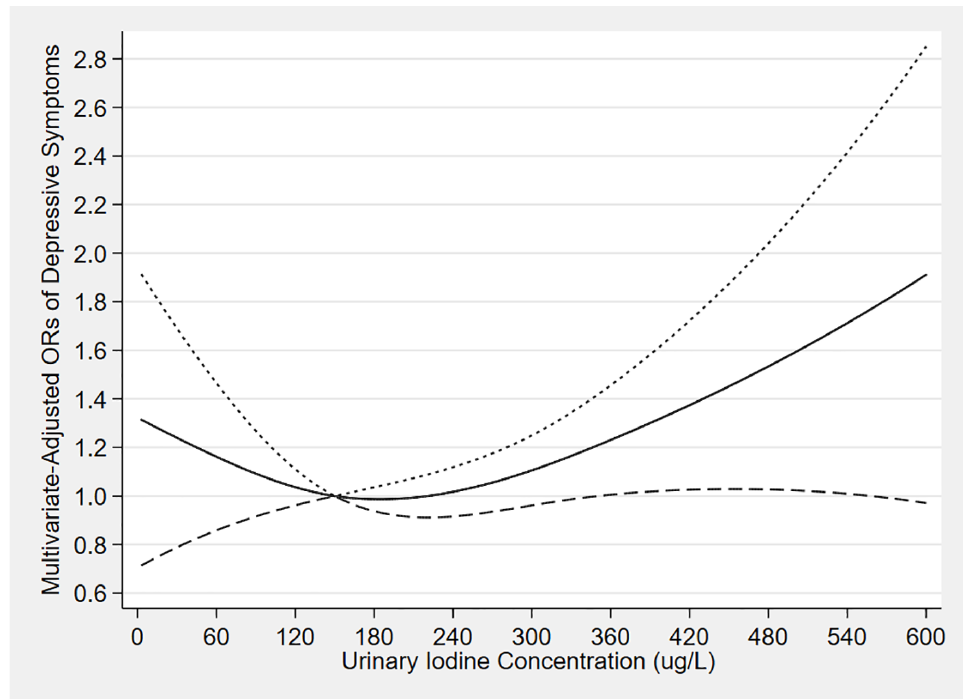
Figure 2. The dose-response relationship between urinary iodine concentration and the risk of depressive symptoms. Adjusted for age, sex, race, education level, annual household income, BMI, marital status, physical activity, caffeine intake, total energy intake, sodium intake, urinary creatinine level, smoking status, drinking status, hypertension, diabetes, and stroke history. Reference is median of the normal UIC group, i.e., 150 μg/L. The solid line and dash line represent the estimated odds ratios (ORs) and their 95% confidence intervals, respectively.